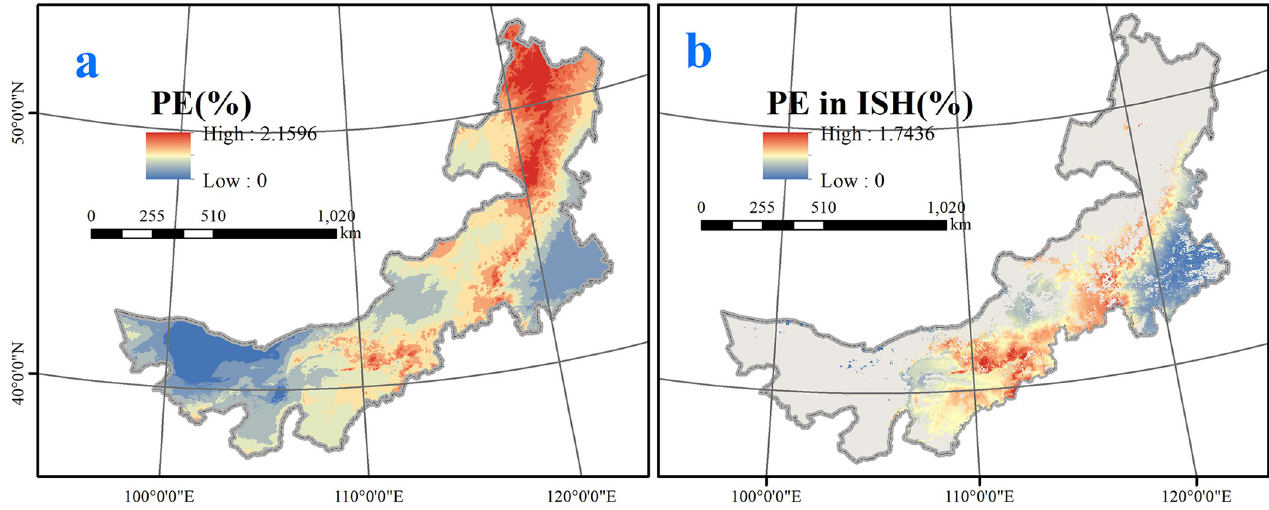
Fig 6. a. PE content across Inner Mongolia; b. PE content in important suitable habitats for E . sinica . This map was made in ArcGIS 10.3 using the resulting rasters produced by the geospatial quality mode and distribution model. The original boundary was obtained from Natural Earth (http://www.naturalearthdata. com).